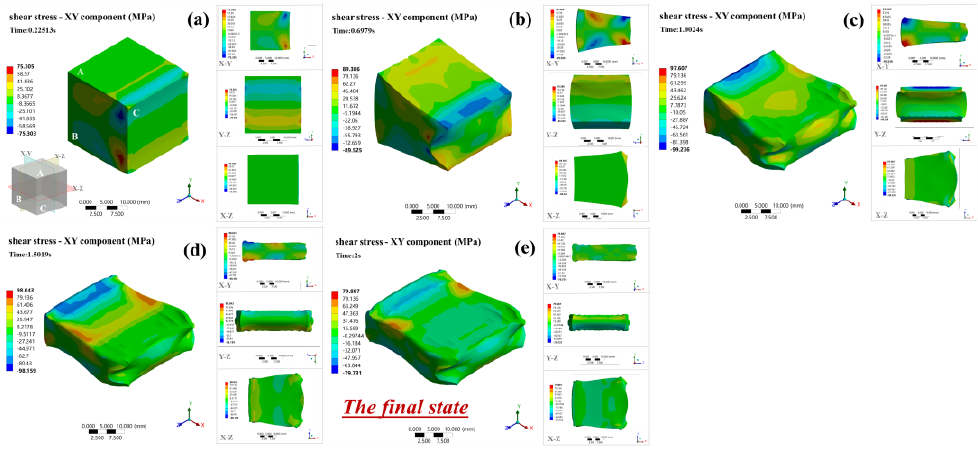
Figure 9. The shear − stress distribution of conventionally rolled alloys. The graphs are cut from different time points of deformation. ( a ) 0.22513 s; ( b ) 0.6979 s; ( c ) 1.0024 s; ( d ) 1.5019 s; ( e ) 2 s.